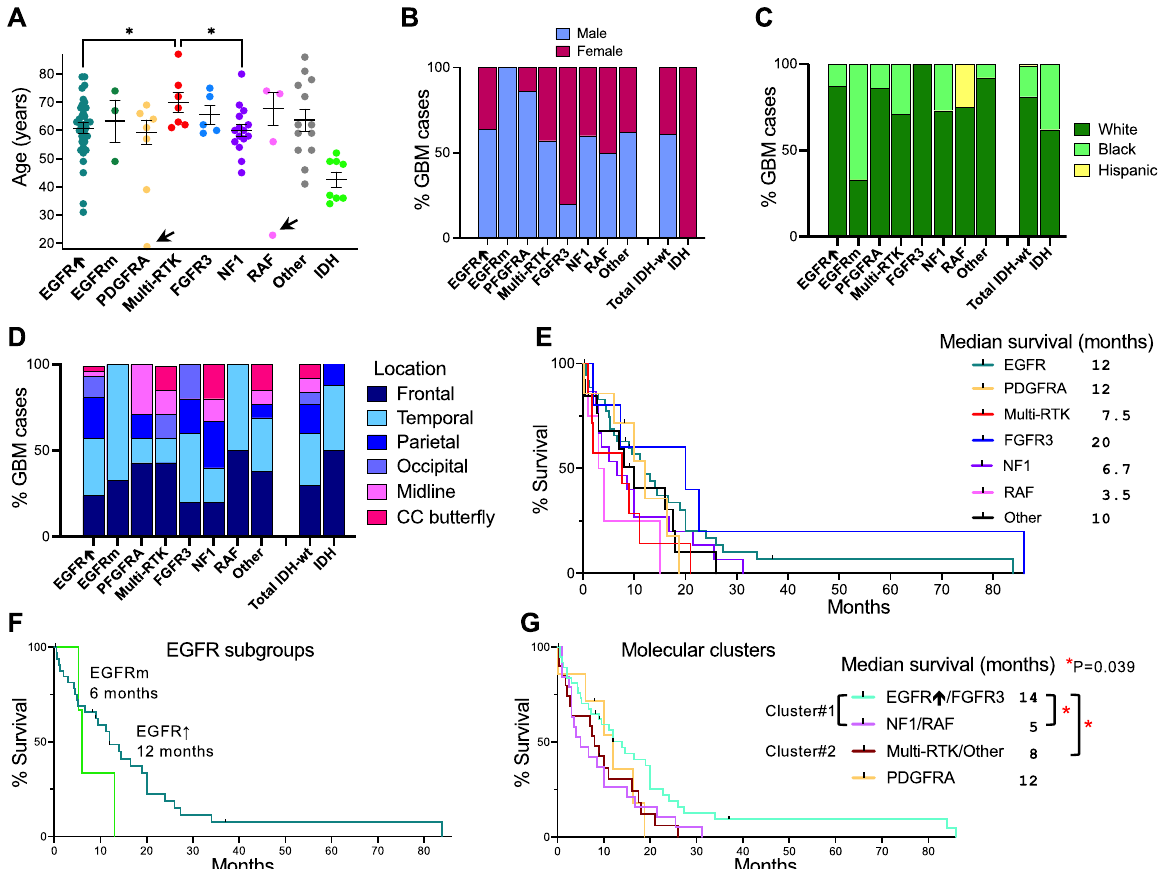
Figure 2. Demographic analysis of glioblastoma subgroups. ( A ) Mean ± SEM of individual age values excluding the outliers indicated by arrows. Statistically significant differences between IDH-wild-type subgroups are indicated by asterisks. ( B ) Sex distribution in glioblastoma subgroups. ( C ) Ethnic/race distribution in glioblastoma subgroups. ( D ) Tumor location distribution showing hemispheric and midline locations, the latter encompassing basal ganglia, pineal gland, and cerebellum. Corpus callosum (CC) symmetric or asymmetric butterfly glioblastoma is shown separately. ( E – G ) Kaplan–Meier survival curves for the 7 IDH-wild-type glioblastoma subgroups ( E ), separated EGFR subgroups ( F ), and molecular clusters ( G ). Median survival and statistical significance ( p -values and asterisks) are